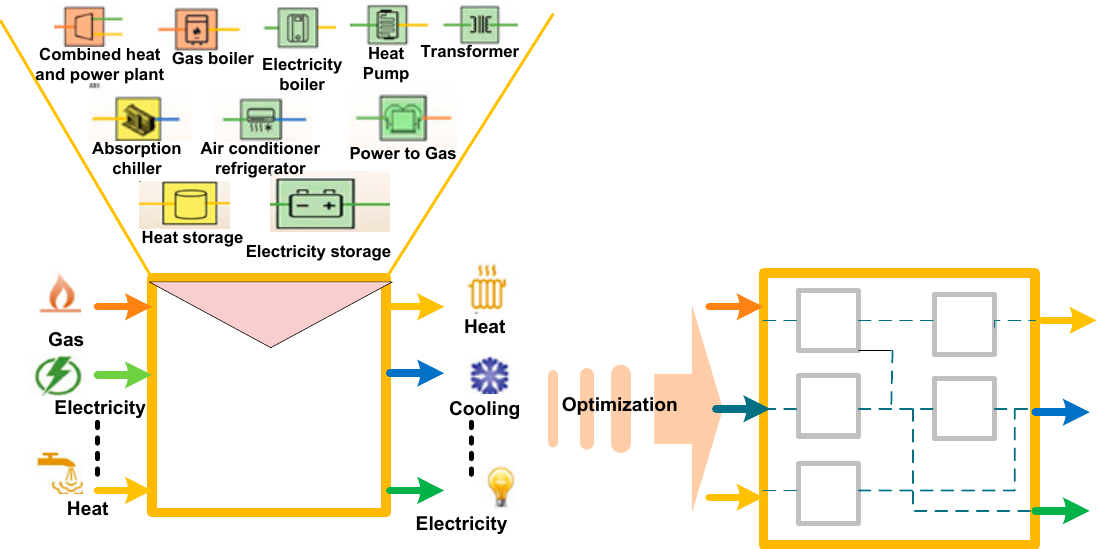
Figure 4. Illustration of energy hub (EH) with all available components [64].